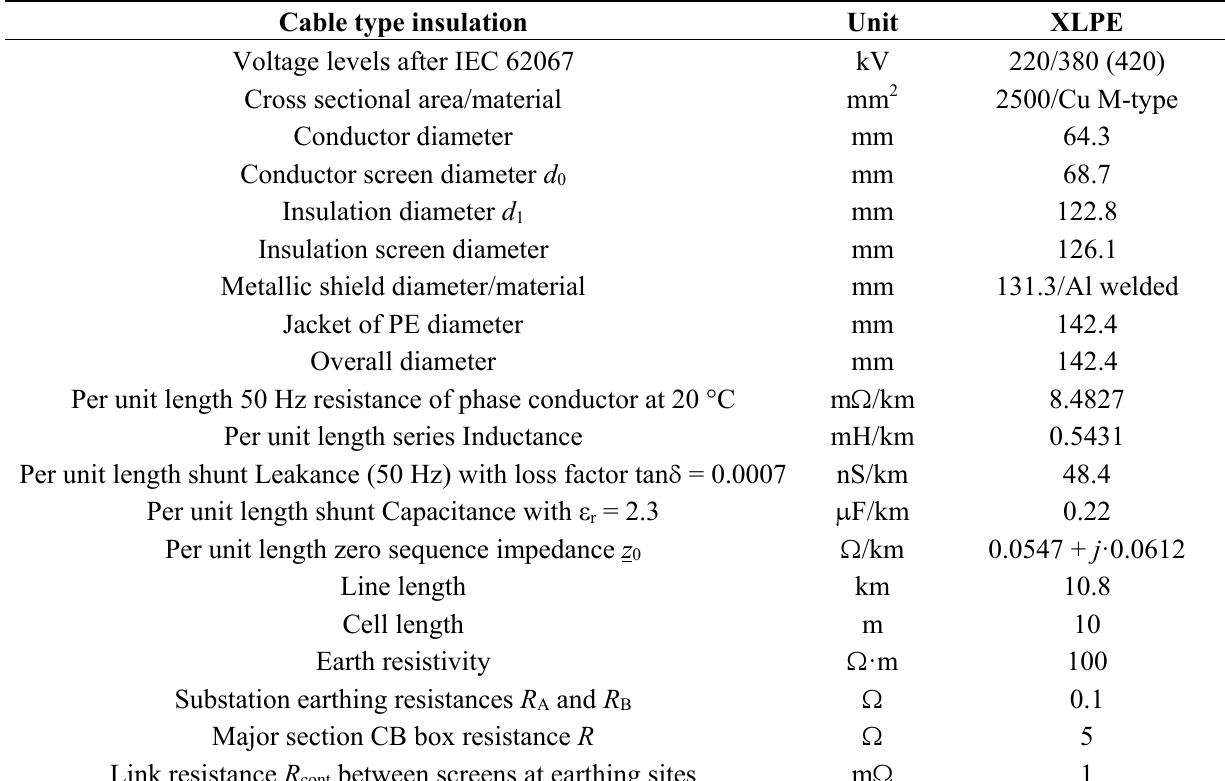
Table 1. Geometric and electric data of XLPE-insulated single-core cable. XLPE: cross-linked polyethylene; PE: polyethylene; CB: cross-bonding.